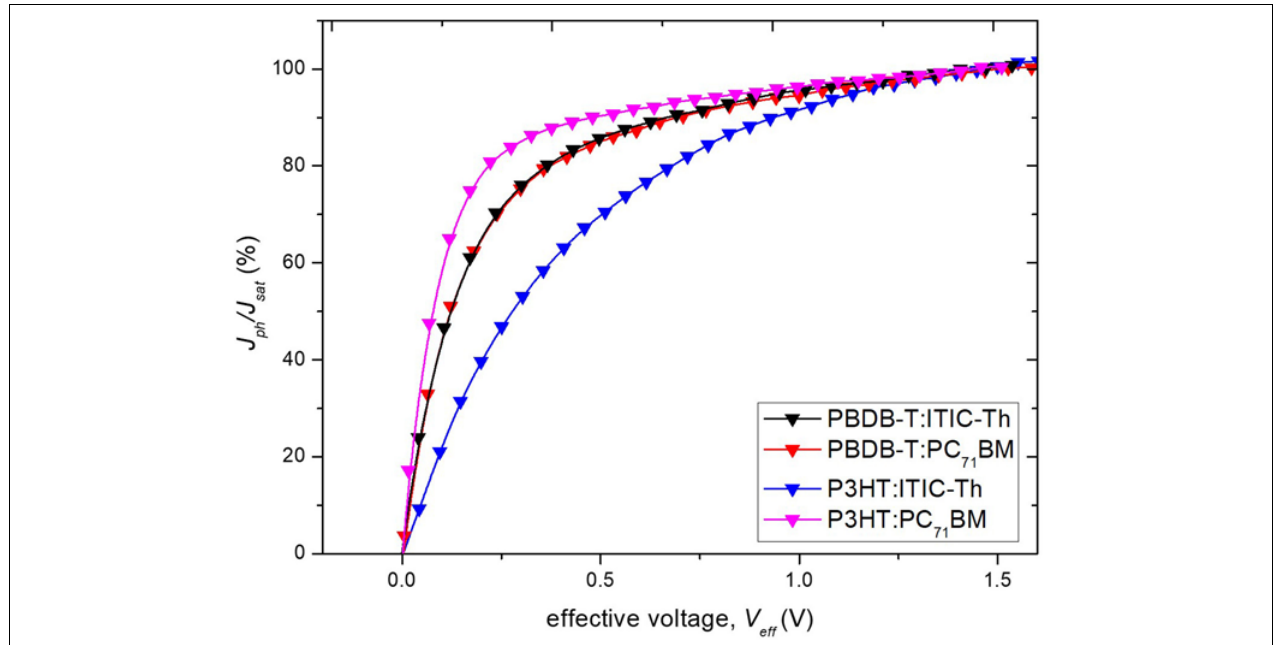
FIGURE 8 | P(E, T) against V eff , where P(E, T) was derived using normalized J ph with J sat (i.e., J ph /J sat ).